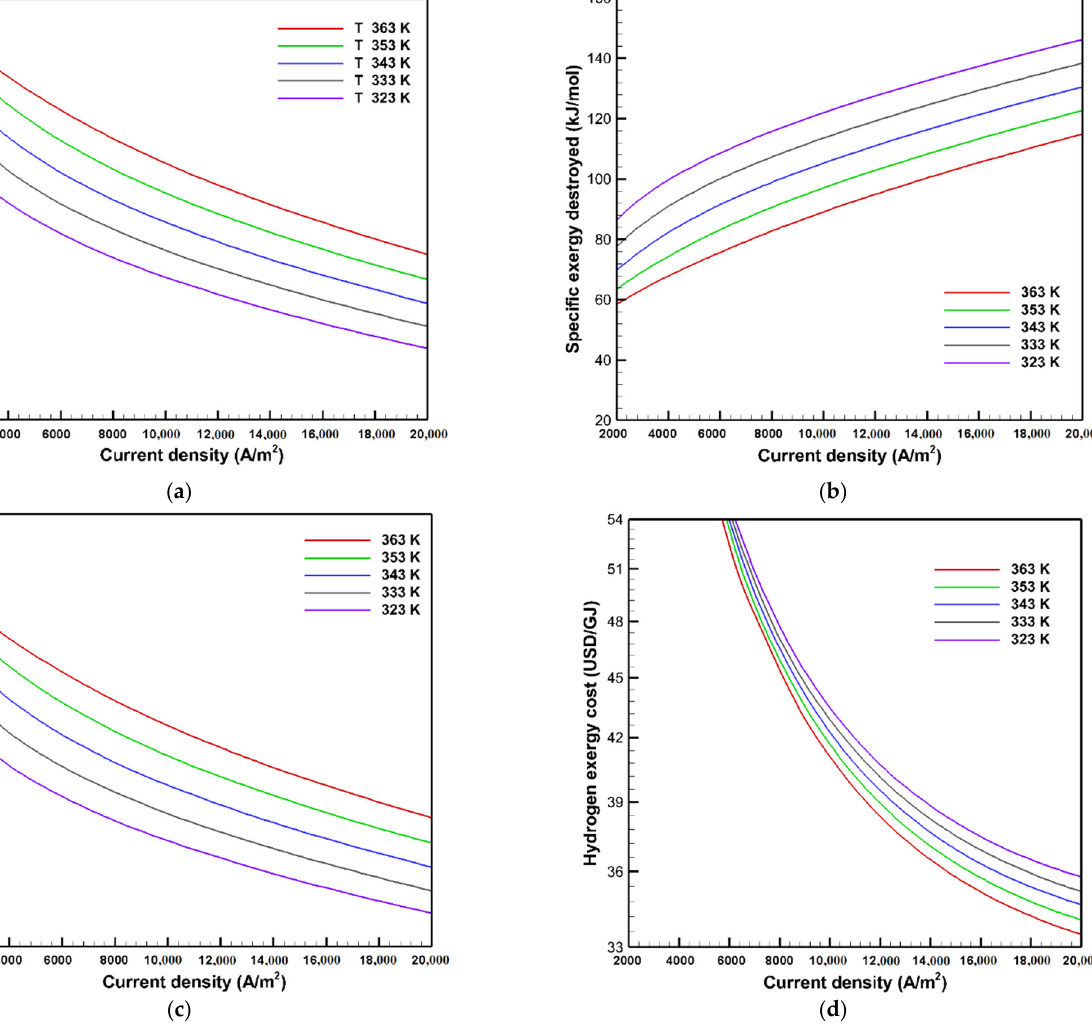
Figure 6. Effects of temperature on: ( a ) voltage efficiency; ( b ) exergy destroyed; ( c ) second law effi- ciency; and ( d ) hydrogen exergy cost.